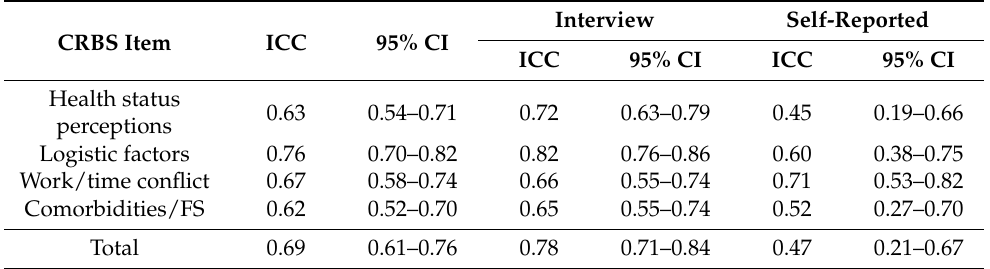
Table 4. Reliability of the Cardiac Rehabilitation Barriers Scale by domains and type of survey. CRBS Item ICC 95%